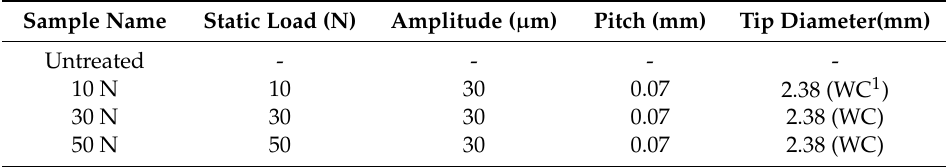
Figure 1. Schematic of the ultrasonic nanocrystal surface modification (UNSM) process. Table 2. UNSM conditions for Alloy 600.